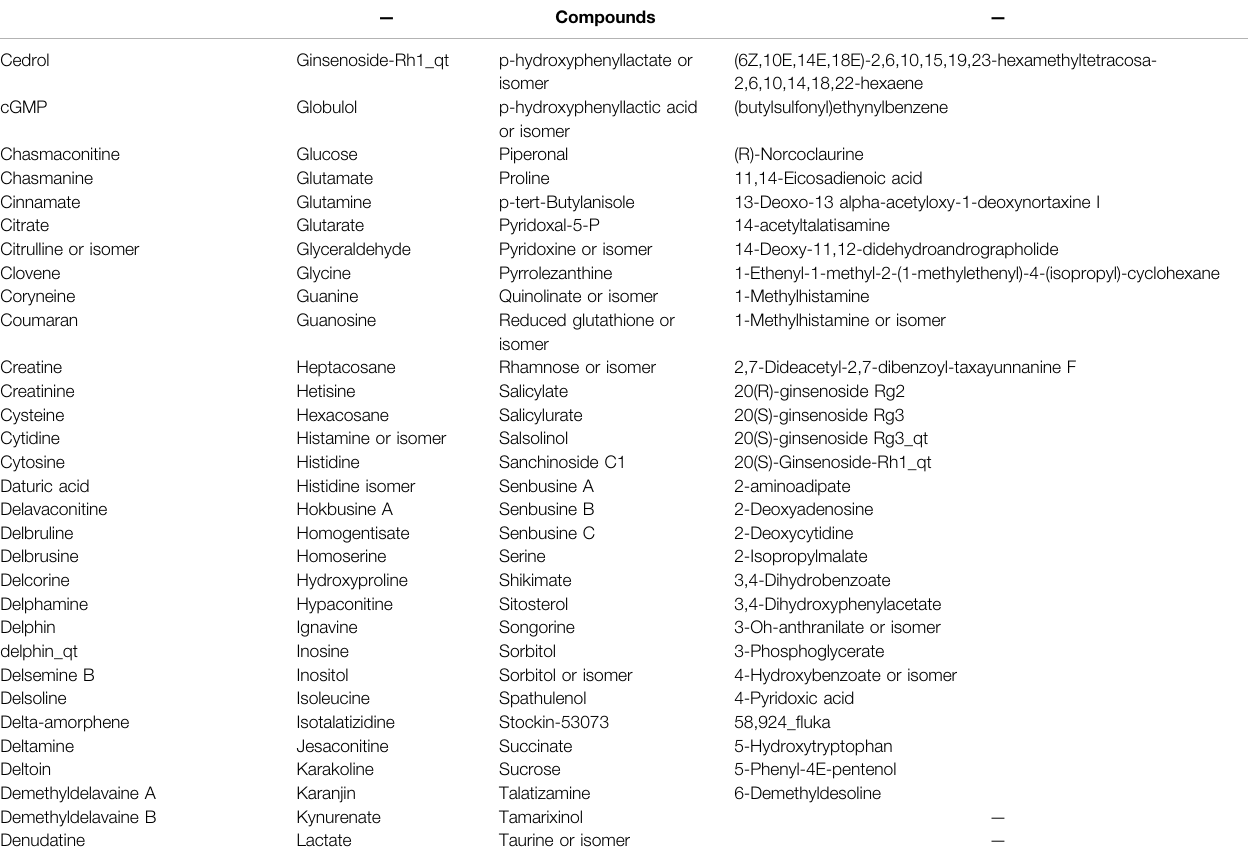
Statistical Analysis Data were presented as mean ± standard deviation (SD). Group comparisons were analyzed with one-way ANOVA after Shapiro-Wilk normality test for normality and Bartlett ’ s test for the homogeneity of variance. The analysis was performed by GraphPad Prism 8. p value < 0.05 was considered statistically signi fi